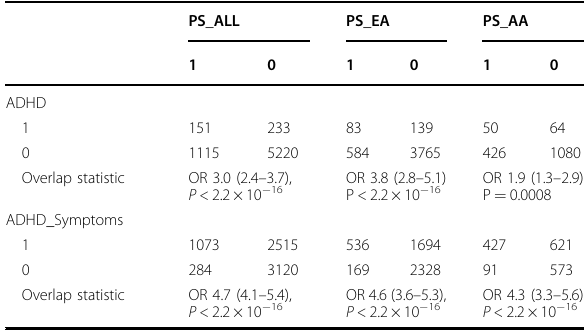
Table 2 Clinical overlap between PS and ADHD across ancestry